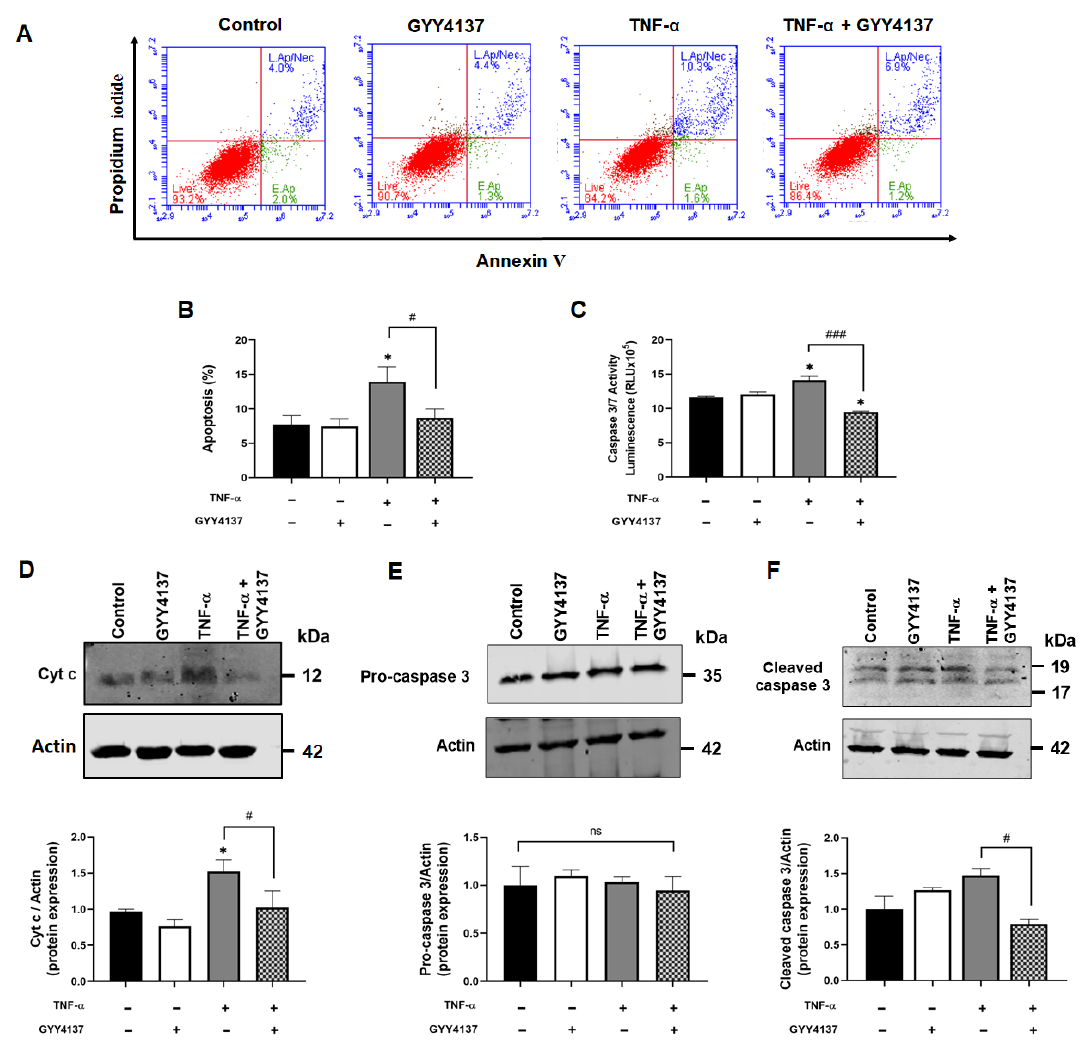
Figure 3. GYY4137 post ‐ treatment arrests intrinsic apoptotic pathway . ( A ) Representative scatter plots showing apoptosis/necrosis (%) detected by Annexin V/Propidium Iodide double ‐ staining with 10,000 events in each replicate. ( B ) Apoptosis (%) in treated HUVECs determined by flow cytometry from three independent experiments ( C ) The activity of Caspase 3/7 was analysed using a Promega ® luminescence assay kit from three independent experiments. ( D ) Western blot analysis for cytosolic cytochrome c (Cyto c) ( E ) pro ‐ caspase 3 and ( F ) cleaved caspase 3 protein expression. p ‐ values were calculated using one ‐ way ANOVA test followed by Tukey’s comparison test. Data are shown as means ± SD; * p < 0.05 vs. control. # p < 0.05 and ### p < 0.001 vs. TNF ‐α‐ treated groups only. N = 3 independent experiments with 3 replicate in each